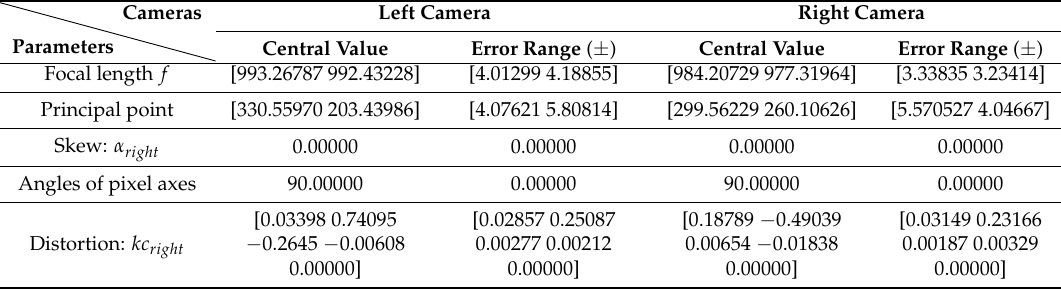
Figure 9. Library robot binocular vision system calibration. ( a ) The original QR code images utilized for calibration. ( b ) The corner-point images extracted from the original QR code images. Table 2. Binocular vision system